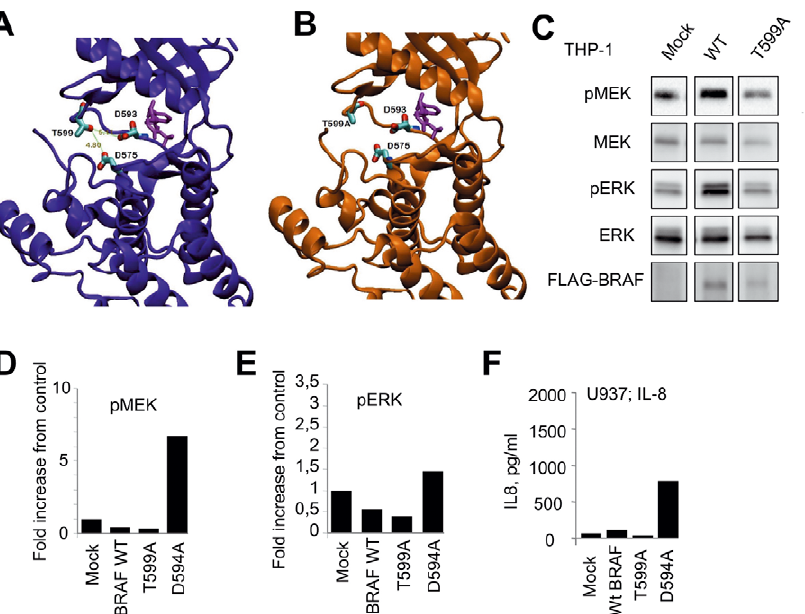
Figure 2. Analysis of T599A B-RAF. ( A, B ) Comparison between models of WT B-RAF 5P_15056 (A, violet) and T599A B-RAF (B, gold). T599A B-RAF substitutes a polar uncharged residue with a hydrophobic residue, causing the loss of short-ranged interactions with residues D576 and D594. C . Analysis of MEK and ERK phosphorylation in THP1 cell lines stably transfected with WT B-RAF-FLAG and T599A B-RAF-FLAG. Experiment was repeated twice with similar results. ( D–F ) Analysis of MEK and ERK phosphorylation and IL-8 production in U937 cell lines stably transfected with WT B-RAF, T599A B-RAF, and D594A B-RAF. Experiment was repeated twice with similar results.